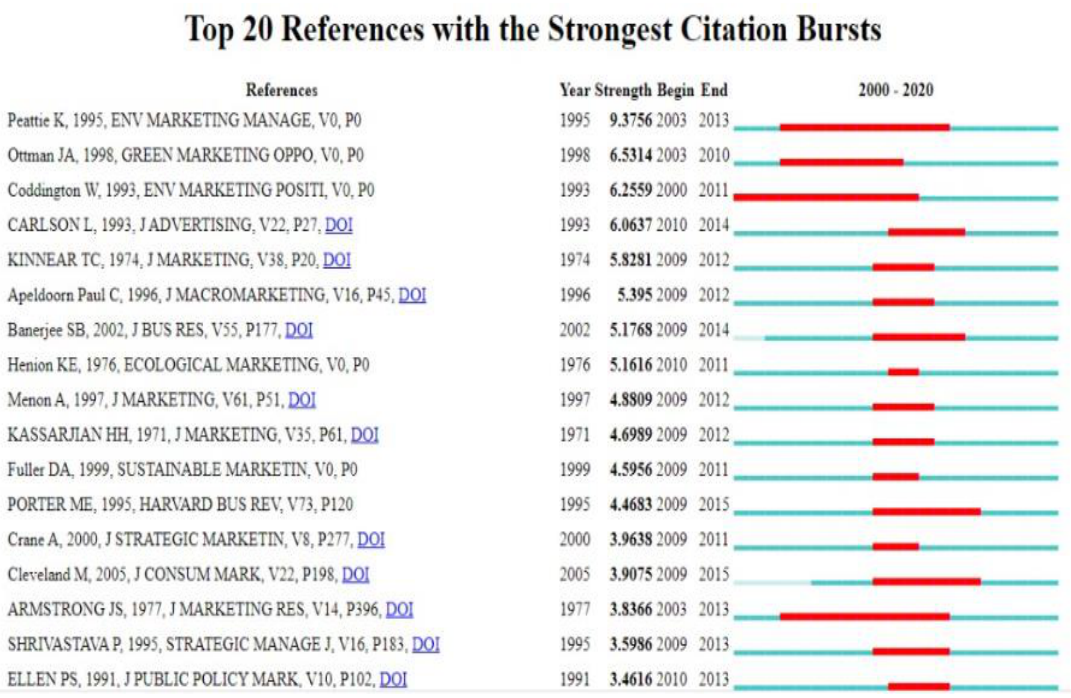
Figure 11. Citation bursts of articles (2000–2020).